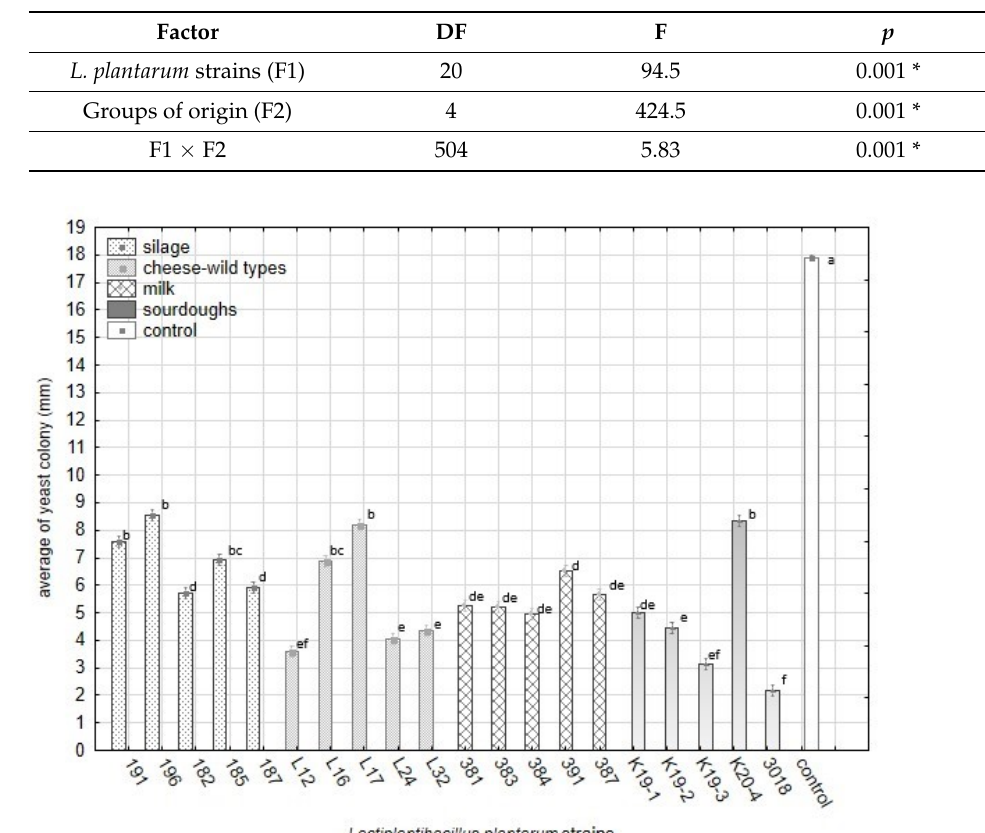
Figure 6. The differences in average sizes (mm) of yeast colonies growing on media with reconstituted milk and lactobacilli strains included in groups of origin (Factorial ANOVA, Statistica Software v. 12, Post Hoc Tukey’s HSD Test). The bars represent means and s.e.m. The index letter indicates significant differences. Significant at α ≤ 0.05. Table 8. The factors influencing in the average size of yeast colonies (mm) on RSM medium with L. plantarum strains, including the control variant, for each yeast strain. Factorial ANOVA, Statistica